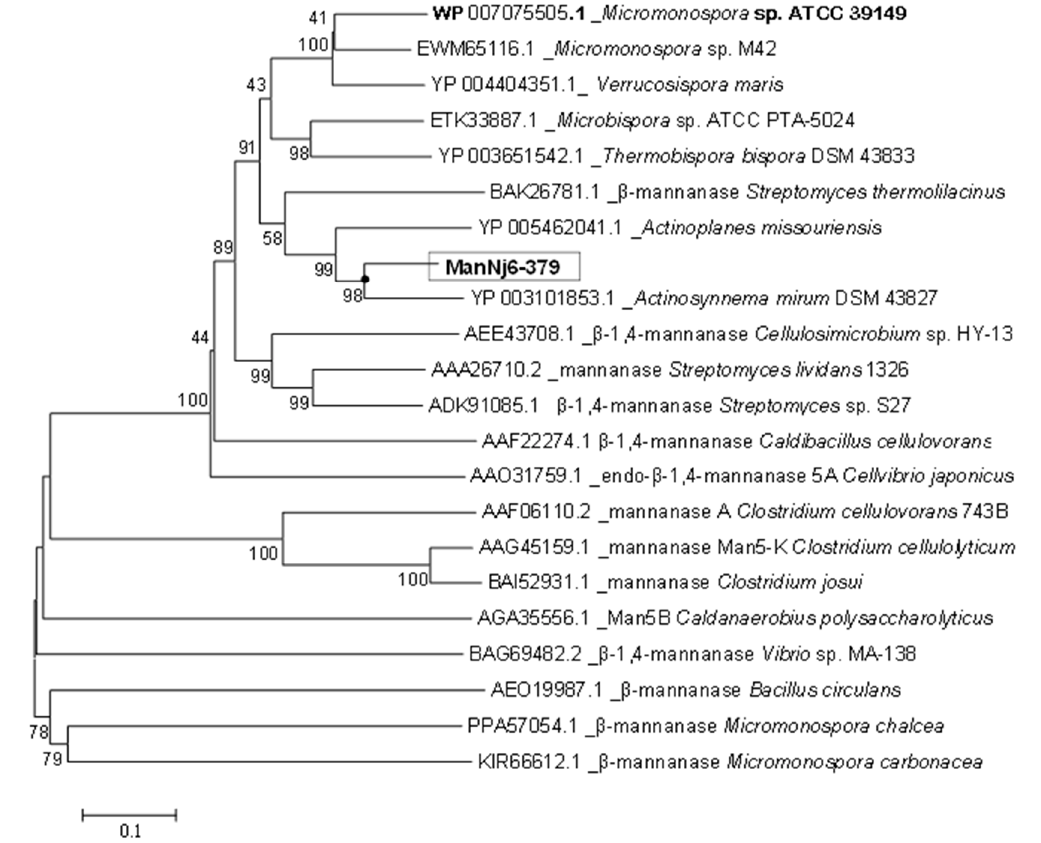
Figure 3. Phylogenetic tree of β -mannanase amino acids showing the relationship to the other 21 strains with a β -mannanase amino acid sequence. The phylogenetic tree was constructed with MEGA 6.0.2 using the neighbor-joining method. Numbers on the branch nodes correspond to the percentage of the bootstrap values for 1000 replicates. Representative sequences in the dendrogram were obtained from GenBank (accession number in parentheses).